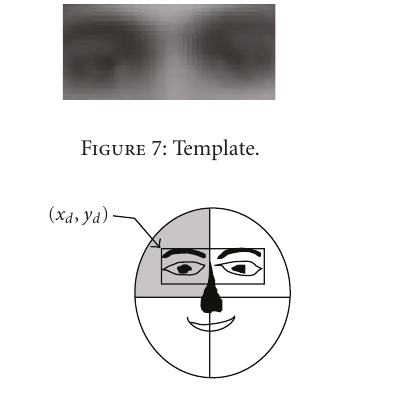
Figure 10: Some samples of segmented faces with di ff erent